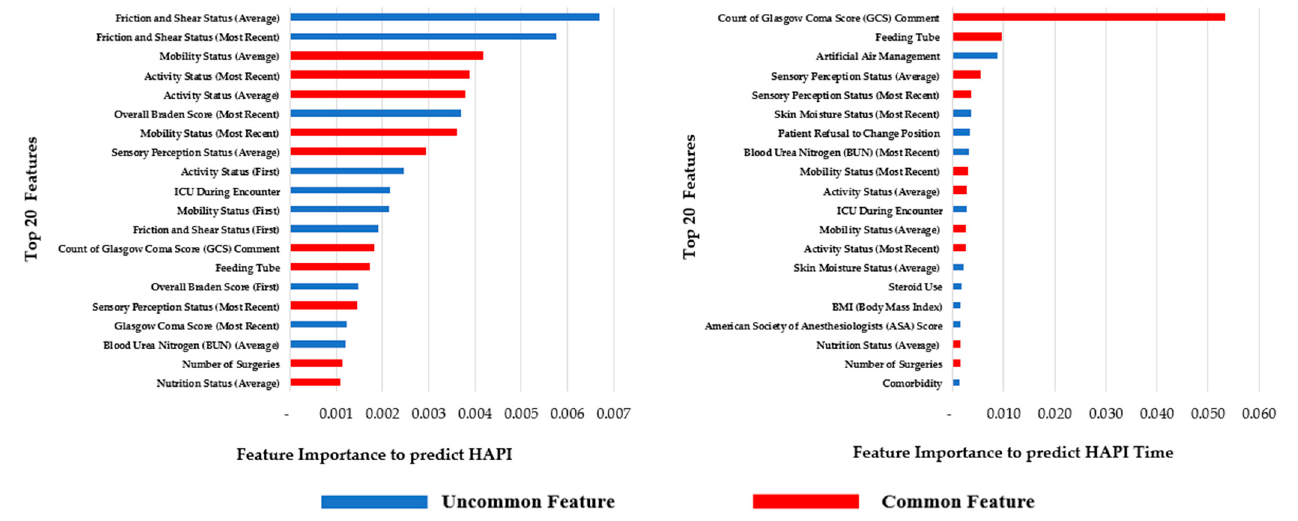
Figure 4. Top 20 features for phase 1 and phase 2. Table 3. Phase 1 results (training with 10-fold cross-validation and